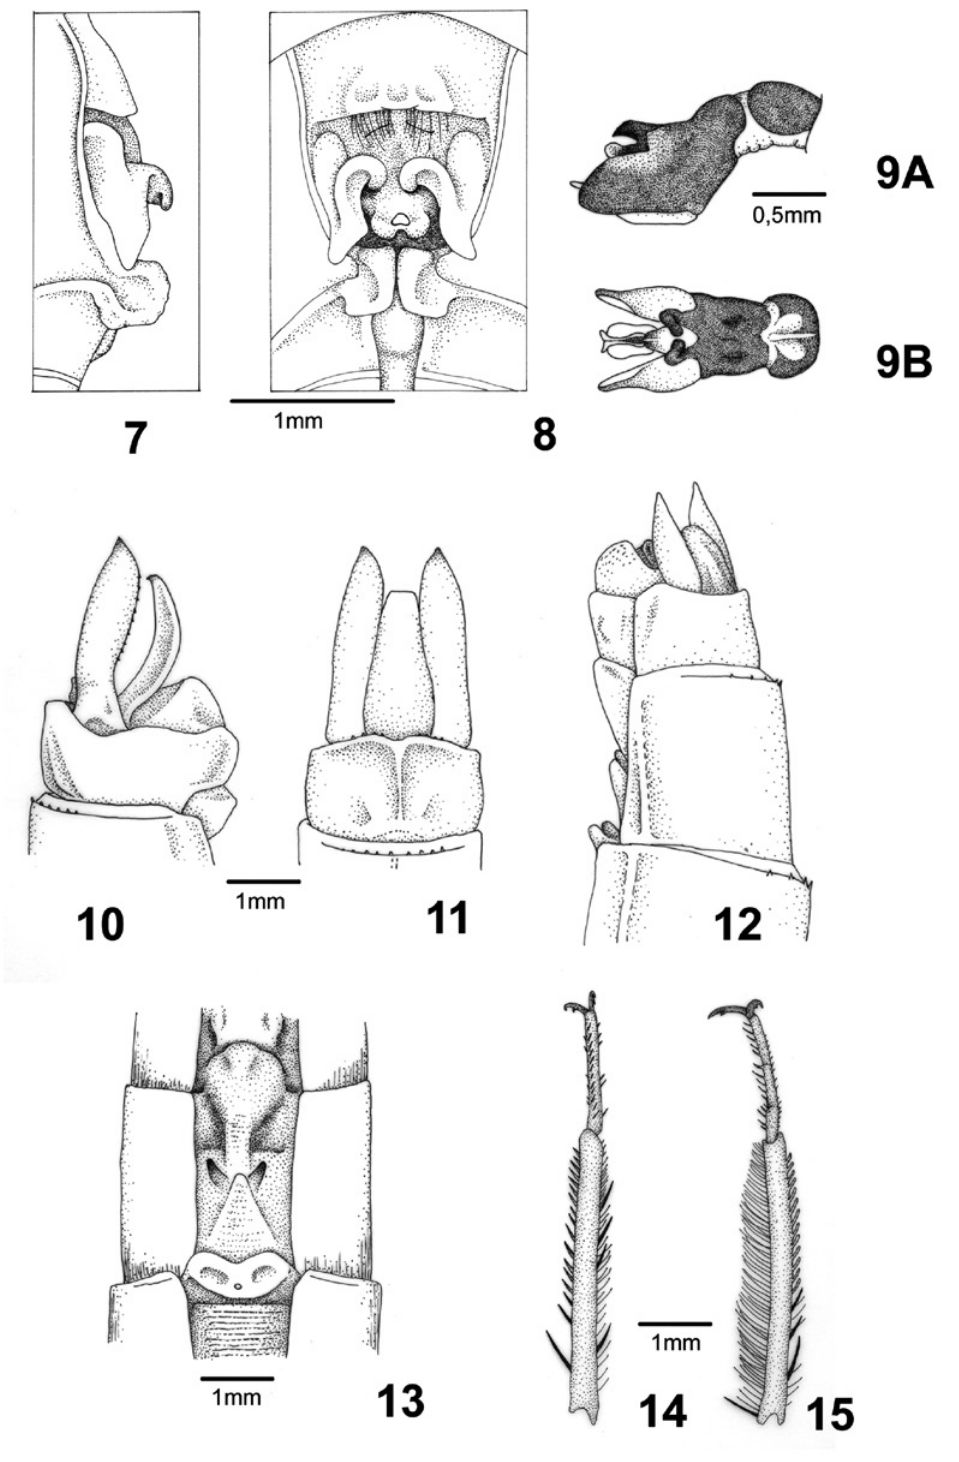
Figs. 7-15 - Carajathemis simone , male holotype. Genitalia of S2 in lateral (7) and ventral (8) views, penis in lateral (9a) and ventral (9b) views; anal appendages in lateral (10) and dorsal (11) views. Female allotype, abdominal segments 9-10 in lateral view (12) segment 9 in ventral (13) , protibia and tarsus internal view (14) , male holotype, protibia and tarsus in internal view (15)